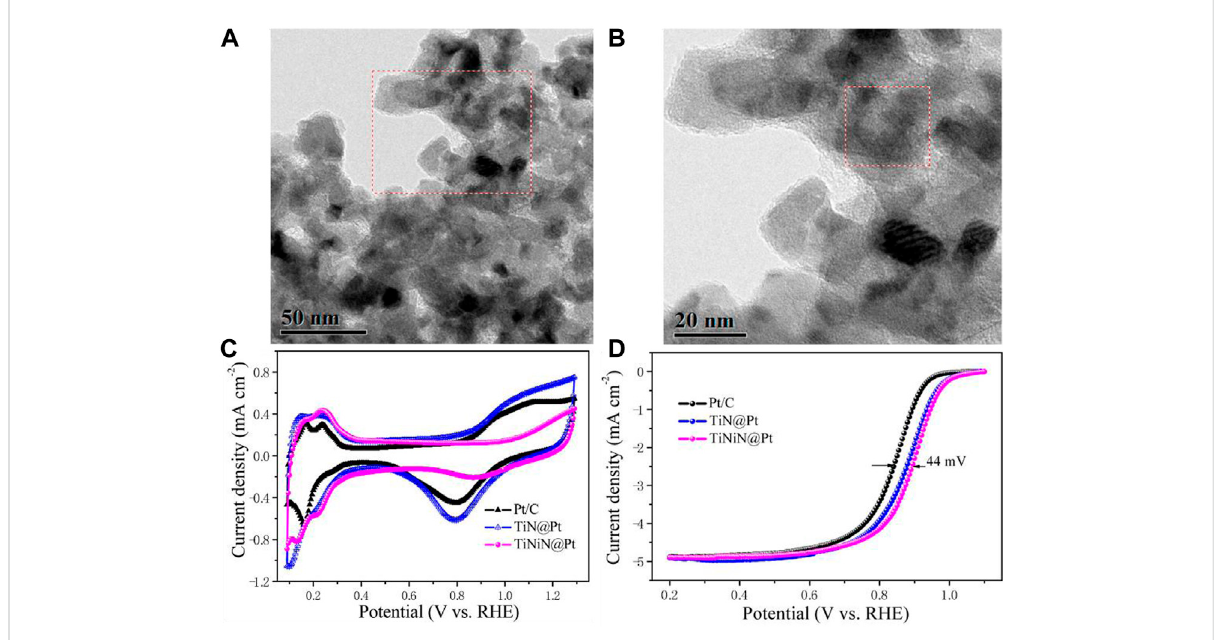
FIGURE 7 (A,B) TEM images of TiNiN@Pt catalyst; (C,D) CV curves and ORR polarization curves of the as-synthesized samples. Reproduced with permission (Tian et al., 2016). Copyright 2016, American Chemical